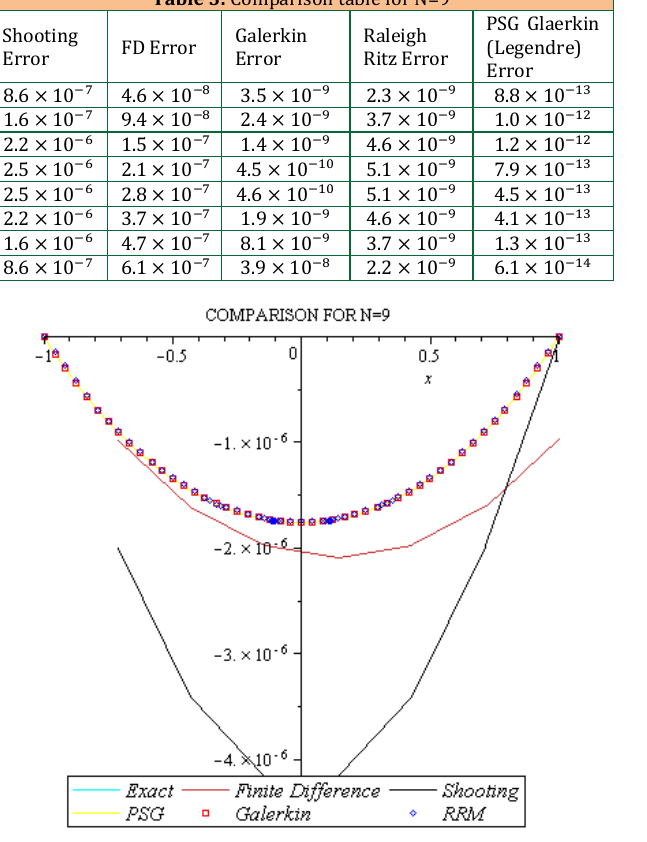
Figure 4: Graphical comparison at